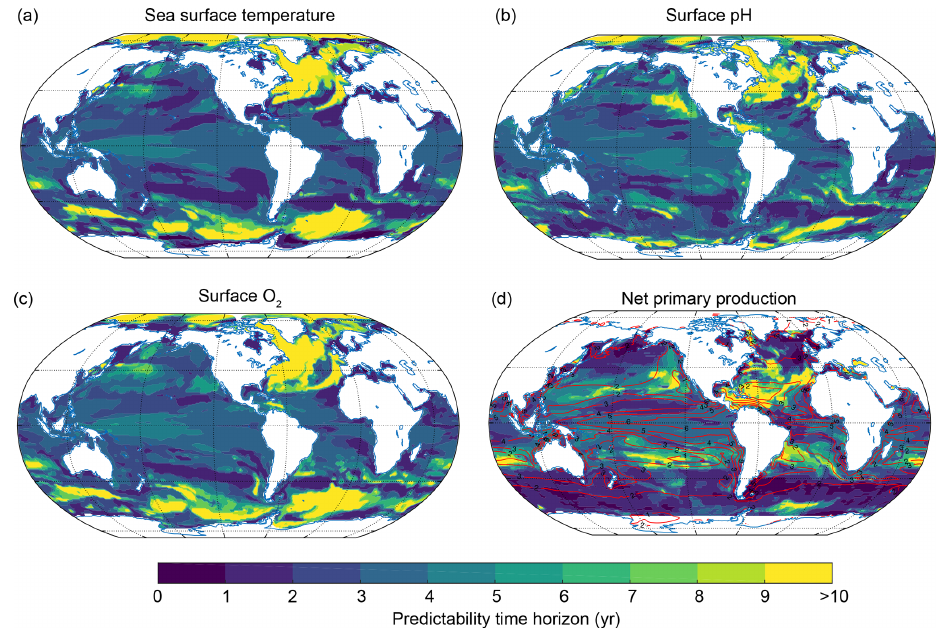
Figure 3. Predictability time horizon for (a) SST, (b) surface pH, (c) surface O 2 and (d) NPP integrated over the top 100m using PPP as a predictability measure. The red contour lines in panel (d) indicate the annual mean total nitrogen production in moles of nitrogen per kilogram per year averaged over the 300-year preindustrial control simulation to highlight regions with low and high NPP. In panel (d) regions north of 69 ◦ N and south of 69 ◦ S have been excluded since NPP is zero during wintertime